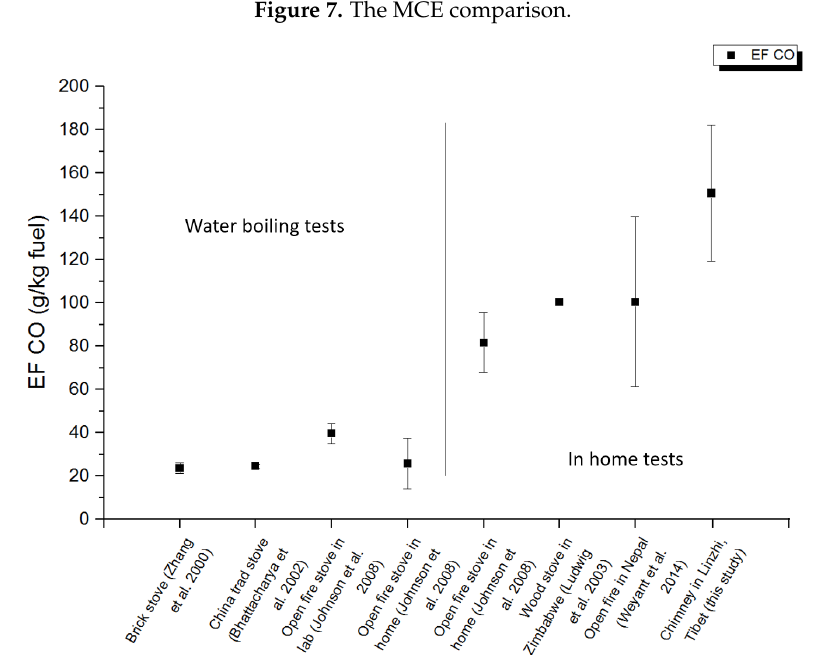
Figure 8. The CO emission factor